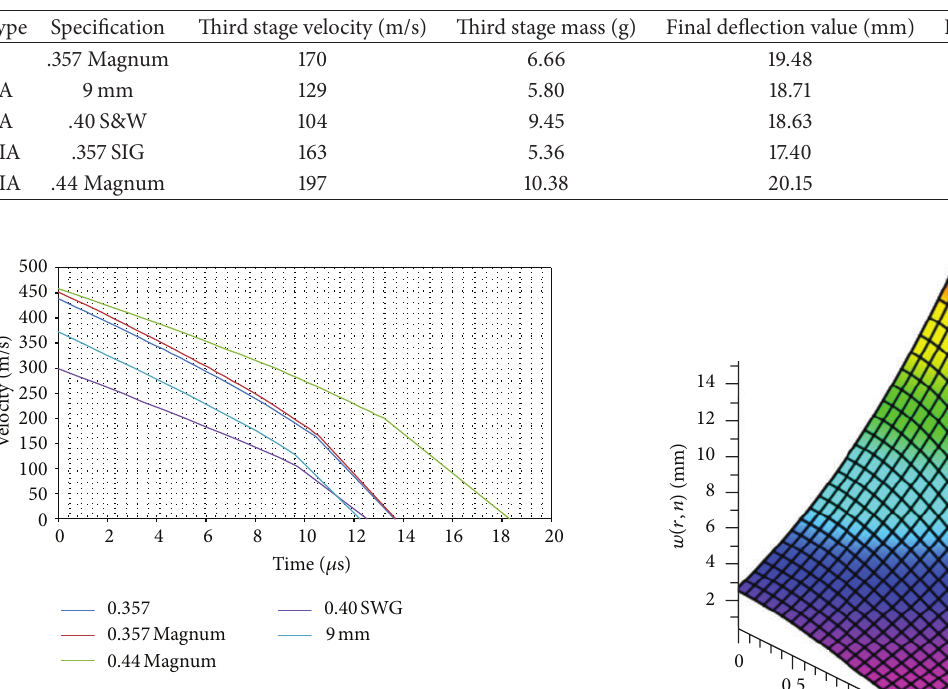
Figure 5: Movement evolution for the simulation on different calibers.